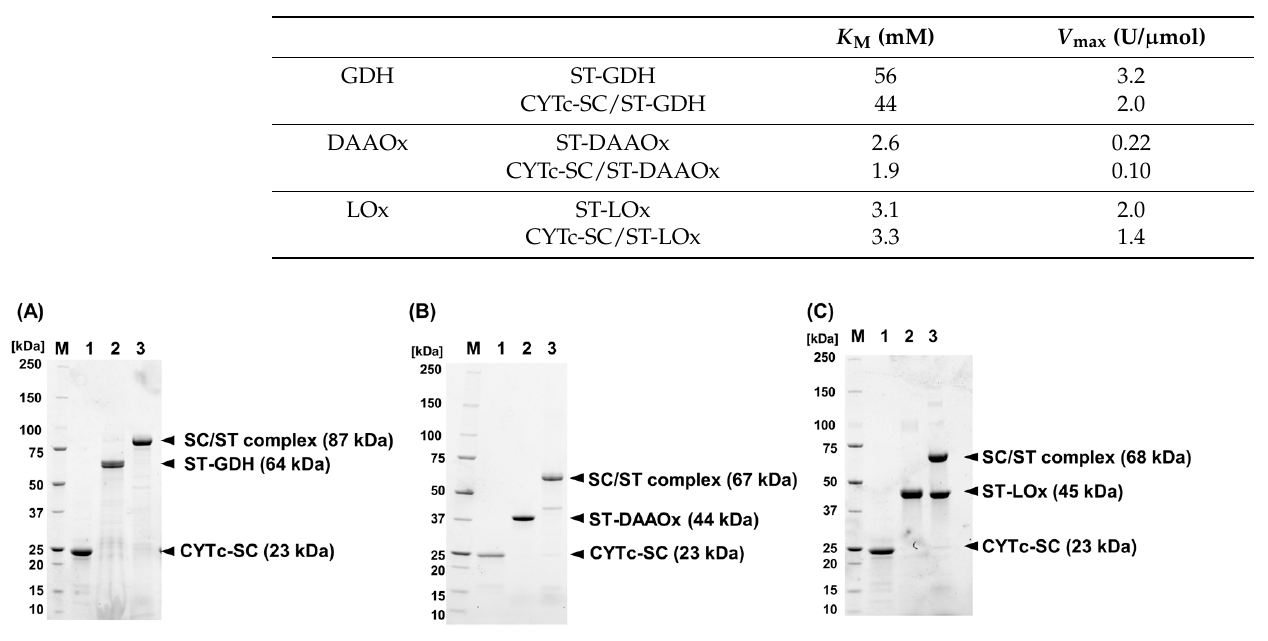
Figure 2. The evaluation of complex formation by SDS-PAGE analyses. ( A ) CYTc-SC/ST-GDH complex, ( B ) CYTc-SC/ST-DAAOx complex, and ( C ) CYTc-SC/ST-LOx complex. M, molecular weight marker; 1, CYTc-SC; 2, ST-Enzyme; and 3, mixed solution of CYTc-SC and each ST-Enzyme. All samples were purified by size-exclusion chromatography before SDS-PAGE analyses. Table 2. Dye-mediated dehydrogenase activities of CYTc-SC/ST-Enzyme complexes or ST-Enzymes.